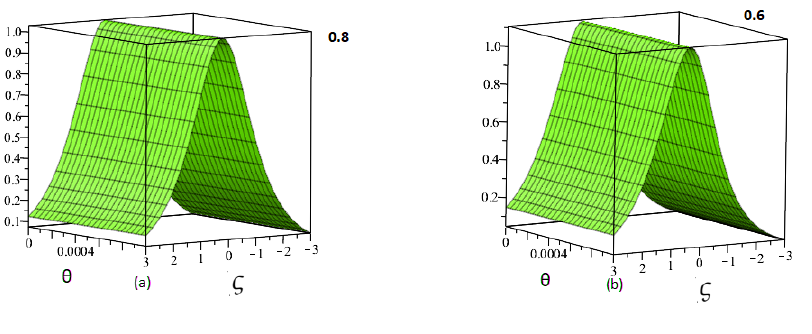
Figure 2. The obtained solution is graphically depicted at ( a ) ℘ = 0.8 and ( b ) ℘ = 0.6.